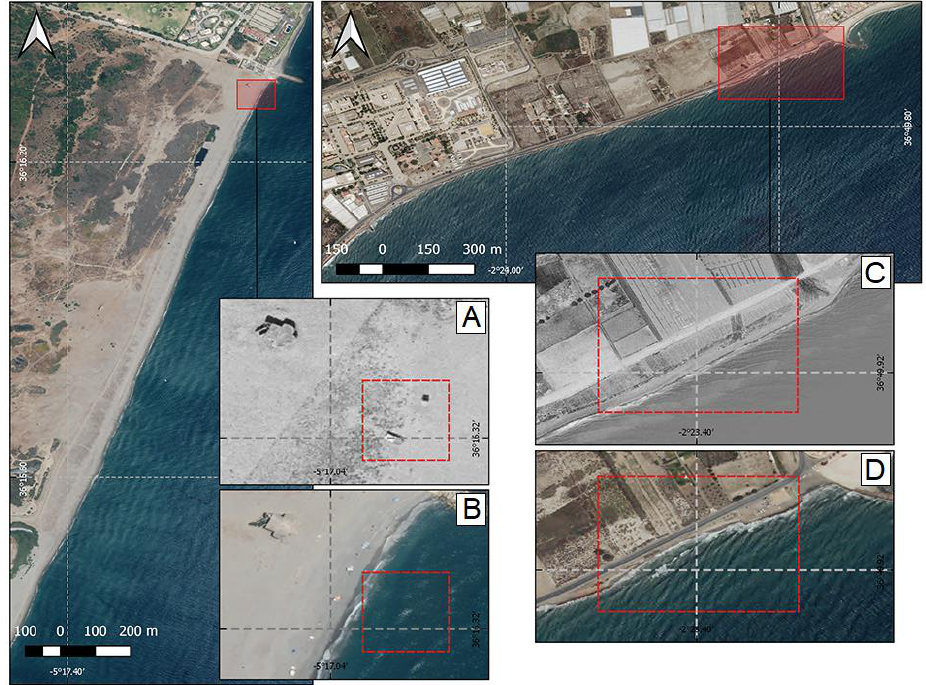
Figure 7. Removal of small constructions in Cádiz and croplands in Almería provinces. System no. 9 Guadalquitón 1977 ( A ), 2016 ( B ), with a decrease of the occupation area of 112.90 m 2 in 1977 – 2001 and 263.31 m 2 in 2001 – 2016. System no. 43 Las Algaidas-Las Marinas in 1977 ( C ) and 2016 ( D ), with a